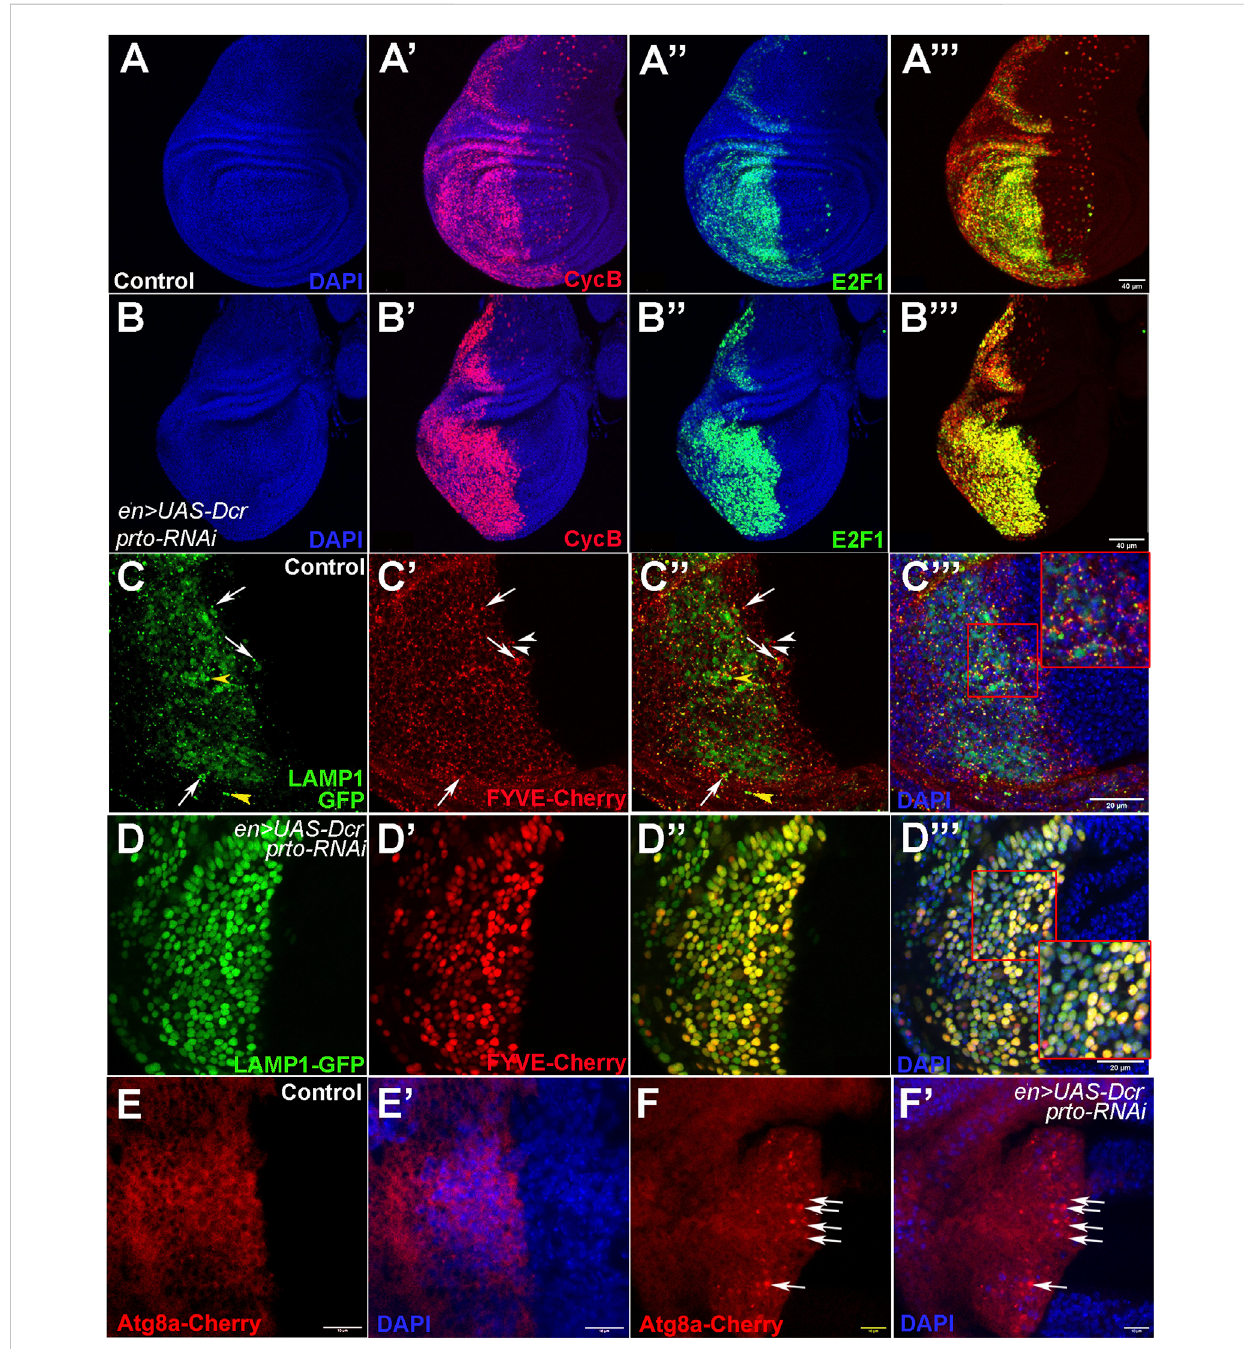
FIGURE 7 Cell cycle progression and endo-lysosomal traf fi cking is disrupted in prto KD epithelial wing cells. (A – A - ) Expression of the FUCCI system in the posterior compartment using en > driver. (A) DAPI expression labelling the nuclei. (A 9 ) DAPI and NLS-dCycB-mRNP expression labelling cells in S and G2 phases and entering Mitosis. (A 9 ) DAPI and dE2F1-GFP expression labelling cells in G1, G2 and mitosis. (A - ) NLS-dCycB-mRNP and dE2F1-GFP expression. (B – B - ) FUCCI expression in the posterior compartment in prto KD wing imaginal disc labelled as in (A) . Note that more epithelial cells in prto KD wing discs seem to be expressing both cell cycle markers suggesting that cells could be a stalled G2-Mitosis transition. Scale bar 40 µm. (C – C - ) Expression of lysosomal (LAMP1-GFP; (C) ) and endosomal (FYVE-cherry; (C 9 ) ) markers in the posterior compartment in control wing imaginal discs. Merged image (C ″ ) and with nuclei (DAPI; (C - ) ). A distinctive puncta pattern of endosomes (white arrowheads) and lysosomes (yellow arrowheads) is observedinthecytoplasmofepithelialcells.Co-localizationofbothmarkersarehighlightedwithanarrow.Highermagni fi cationisshownininsetin (C - ) . Scale bar 20 µm. (D – D - ) prto KD wing imaginal disc labelled as in (C) . The patterns of endosomes and lysosomes have become broader. Higher magni fi cation is shown in inset. Scale bar 20 µm. (E,F) Expression of an Atg8a-Cherry construct in the posterior wing compartment with en > UAS-Dcr control (E) and with prto-RNAi (F) .Mergewith DAPI (E 9 ) and (F 9 ) respectively. An increase of aberrant autophagosomes inposterior isobserved in prto KD discs (arrows). Scale bar 20